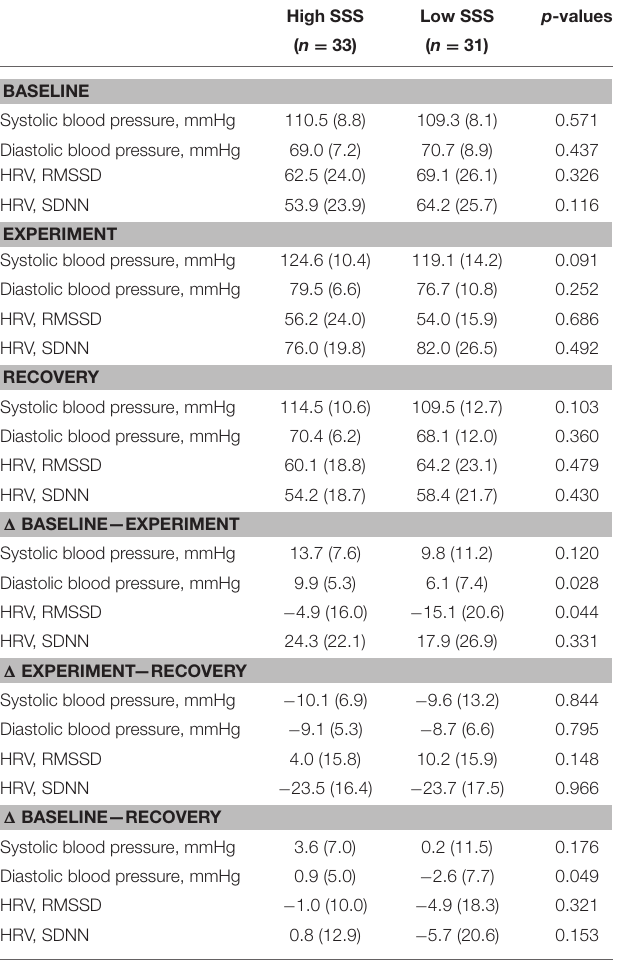
TABLE 2 | Cardiovascular measures at baseline, experimental manipulation, recovery, and change scores